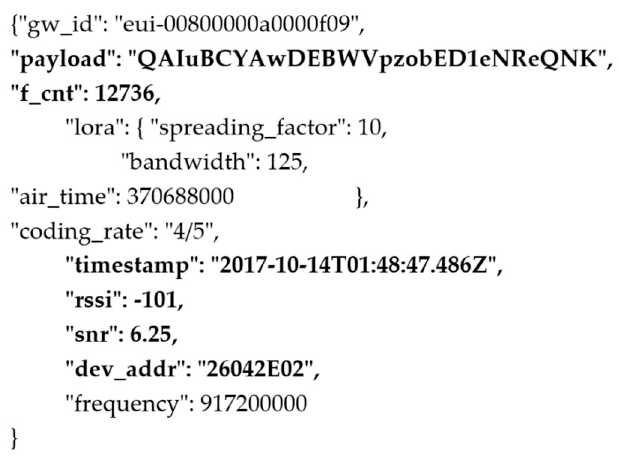
Figure 28. TTN Event packet capture.